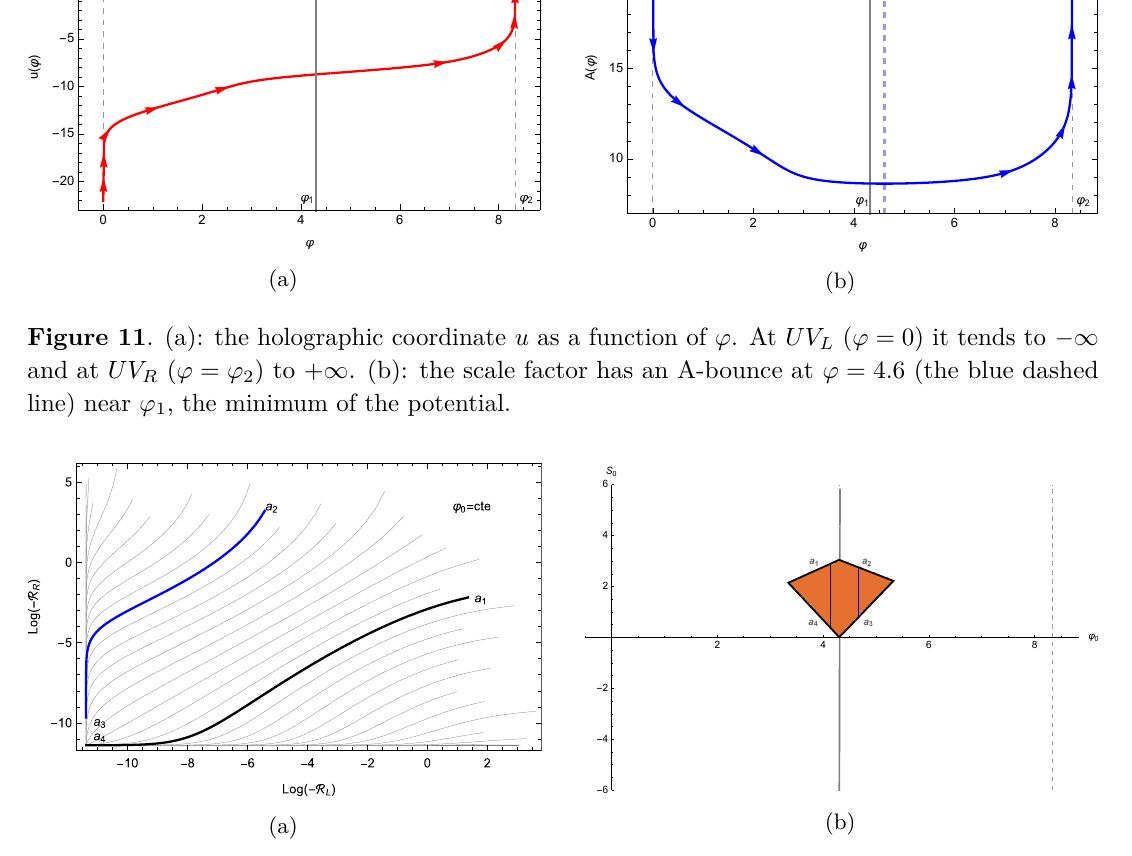
= 93 . Similarly the black curve is at ϕ 0 20